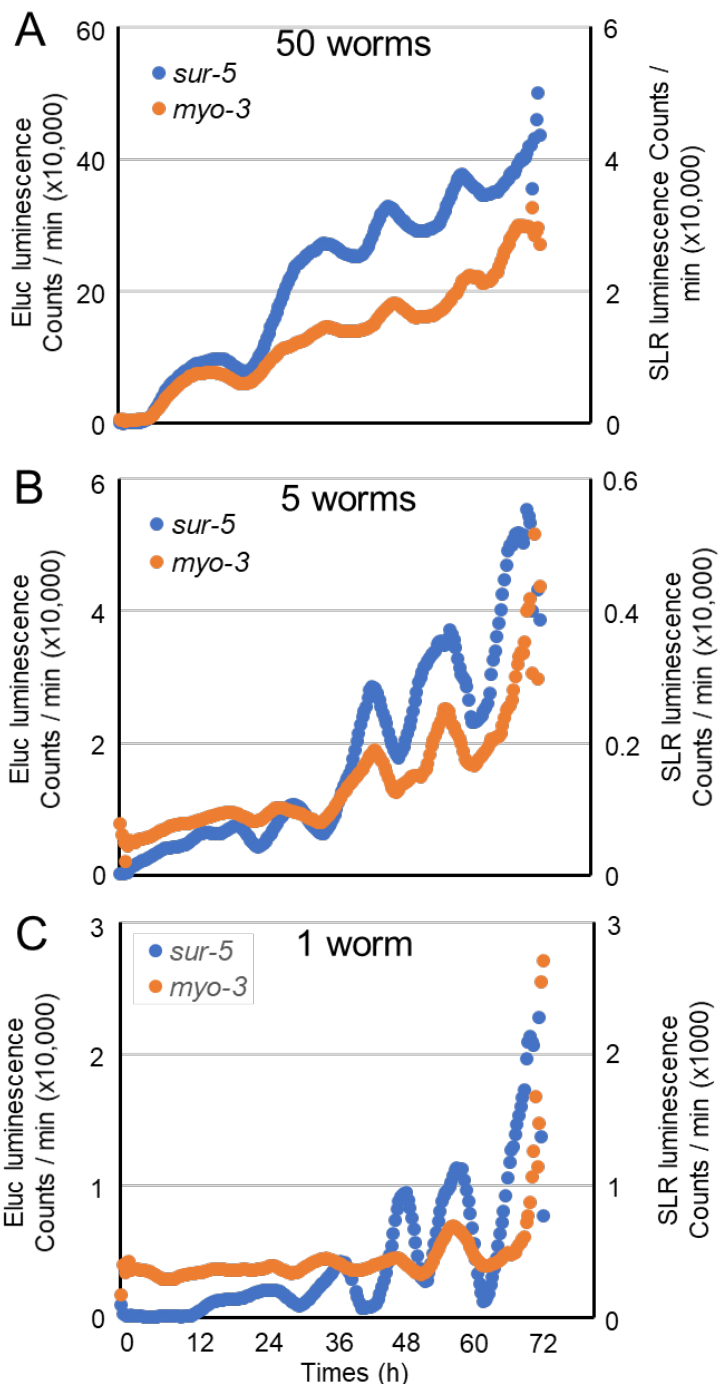
Figure 3. Representative traces of both Eluc and SLR luminescent changes during worm develop- ment in ( A ) fifty animals, ( B ) five animals and ( C ) a single animal. Left and right Y axes indicate luminescent counts for Eluc and SLR, respectively.